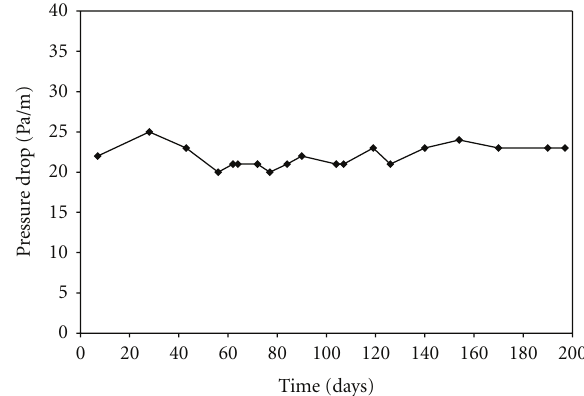
Figure 4: Pressure drop as a function of time in the PM3